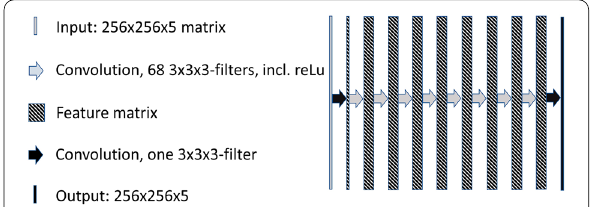
Fig. 1 Diagram of the denoising CNN architecture. A mean squared error loss and a stochastic gradient descent optimizer was